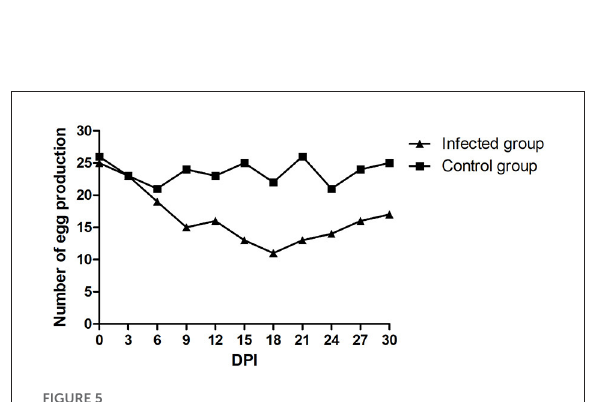
FIGURE5 Daily egg production after the experimental